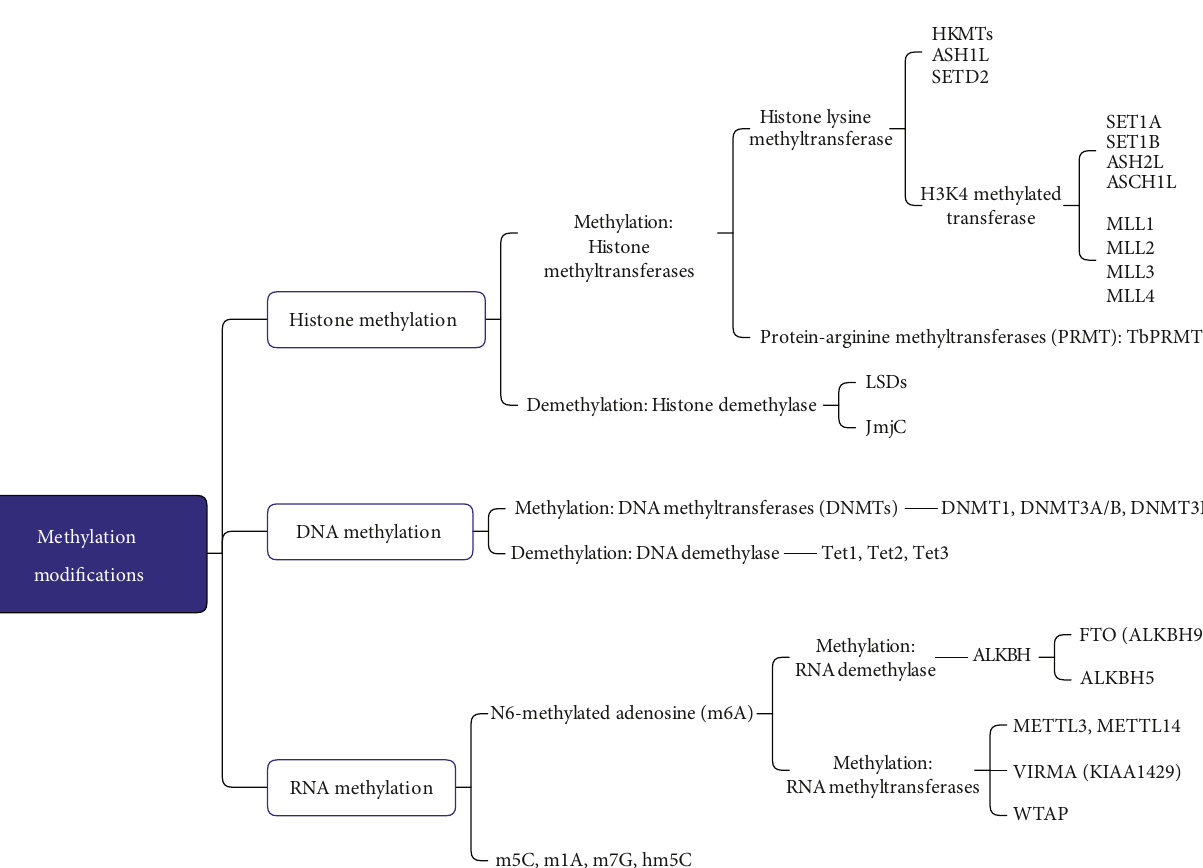
Figure 2: Methylation modi fi cations ’ classi fi cation and main enzymes involved in methylation. Methylation modi fi cations include DNA methylation, histone methylation, and RNA methylation. The enzymes include methyltransferase and